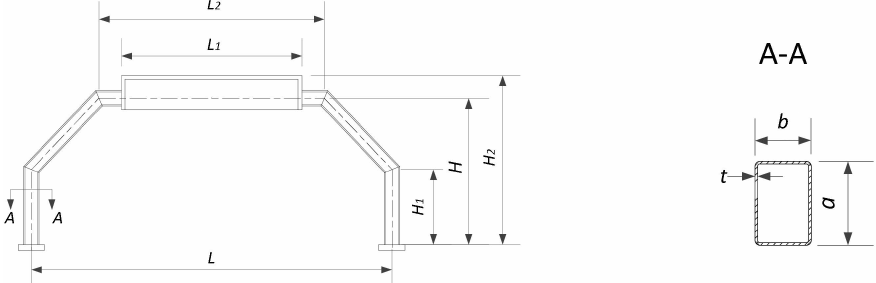
Figure 2. Parameters of five-segment tubular C-shaped frame.